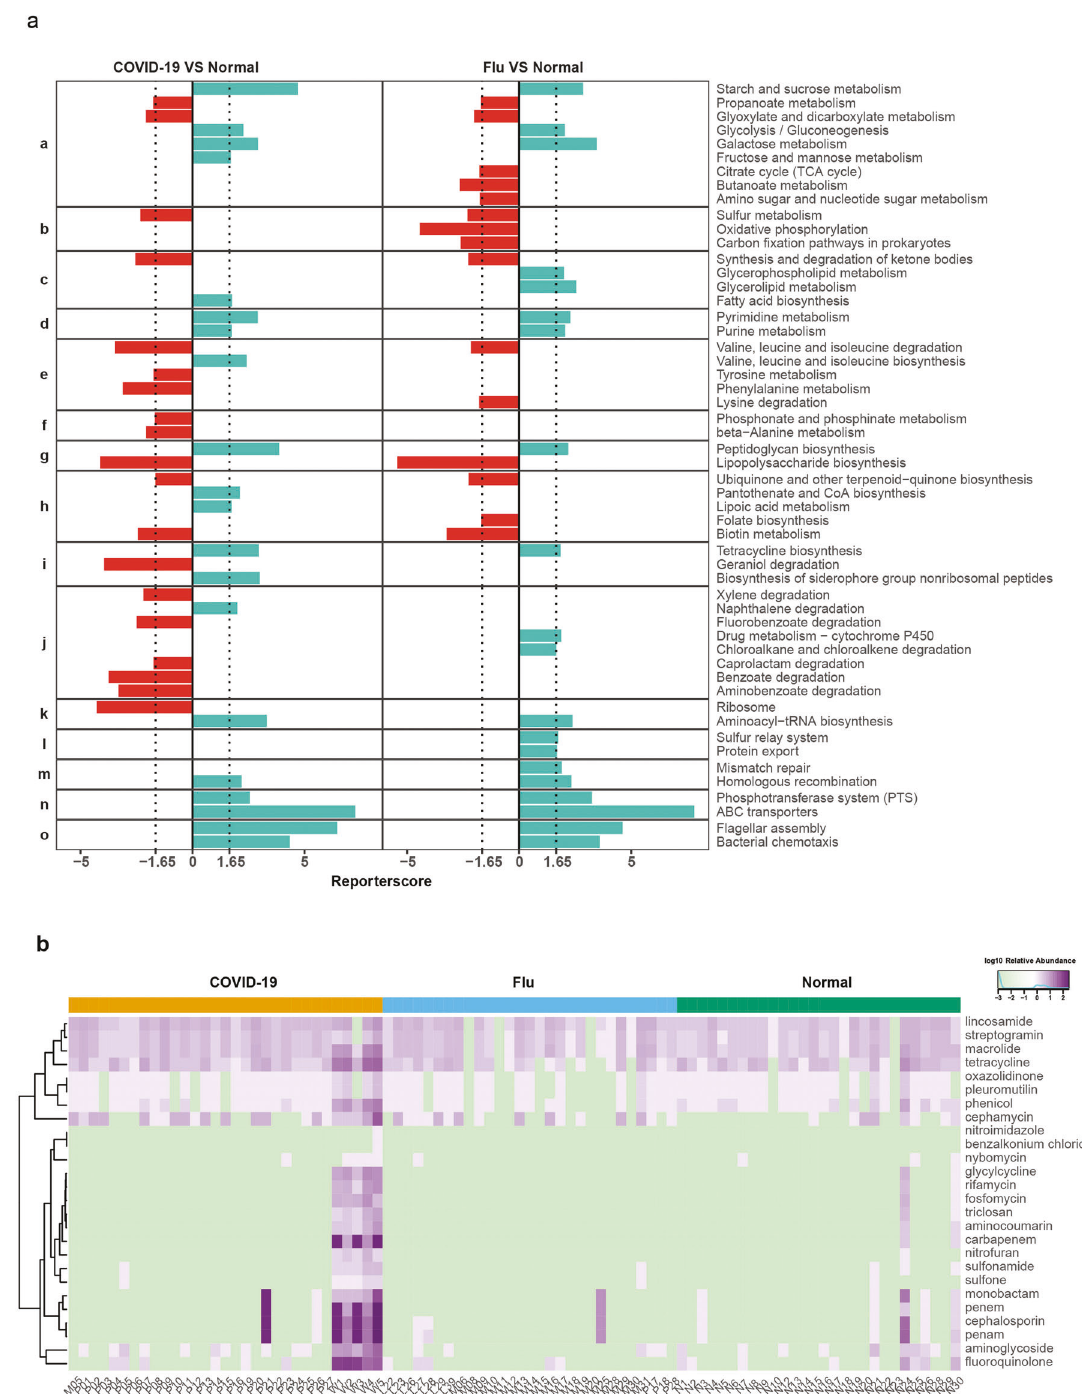
Fig. 5 Differential enrichment of KEGG functions in COVID-19 and fl u patients. a Differential enrichment of KEGG functions in COVID-19 and fl u patients: (a) carbohydrate metabolism. (b) Energy metabolism. (c) Lipid metabolism. (d) Nucleotide metabolism. (e) Amino acid metabolism. (f) Metabolism of other amino acids. (g) Glycan biosynthesis and metabolism. (h) Metabolism of cofactors and vitamins. (i) Metabolism of terpenoids and polyketides. (j) Xenobiotic biodegradation and metabolism. (k) Translation. (l) Folding, sorting, and degradation. (m) Replication and repair. (n) Membrane transport. (o) Cell motility. Red, case-enriched and cyan, control-enriched within each disease cohort (NCOVID-19 = 31, NFlu = 29, and NNormal = 28). Dashed lines indicate a reporter score of 1.96, corresponding to the 95% con fi dence of a normal distribution. b Heatmap indicating the relative abundance of AMR genes in 26 drug classes of the three groups